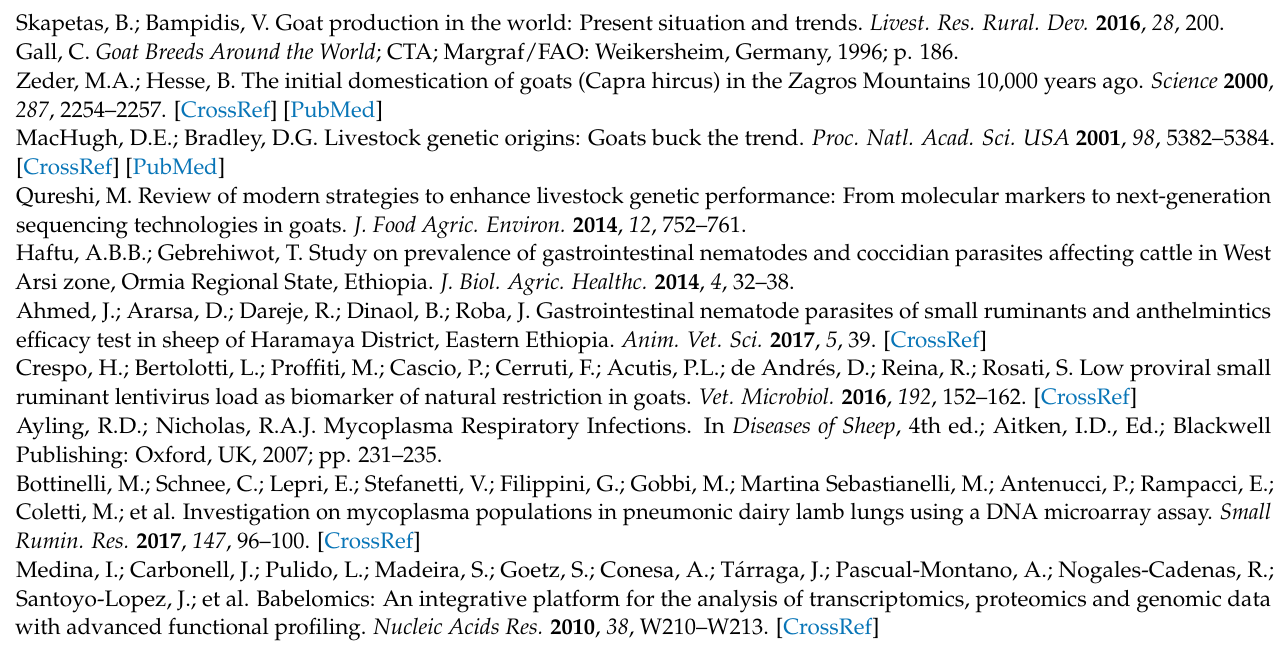
Figure S15: Comparison of healthy and pneumonia-affected Baladi goats using GenBank-sourced reference sequence gb|XM_013962543.2| and the ADORA3 gene (521-bp), demonstrating DNA sequence alignment, Figure S16: Comparison of healthy and pneumonia-affected Baladi goats using GenBank-sourced reference sequence gb|KJ001638.1| and the CARD15 gene (394-bp), demonstrating DNA sequence alignment, Figure S17: Comparison of healthy and pneumonia-affected Baladi goats using GenBank-sourced reference sequence gb|JQ308793.1|and the IRF3 gene (468-bp), demon- strating DNA sequence alignment, Figure S18: Comparison of healthy and pneumonia-affected Baladi goats using GenBank-sourced reference sequence gb|XR_001917340.1| and the SCART1 gene (475-bp), demonstrating DNA sequence alignment, Table S1: Immune gene oligonucleotide primer sequence used in PCR-DNA sequencing, Table S2: Sequence of the oligonucleotide primers used in real-time PCR for immunological genes under